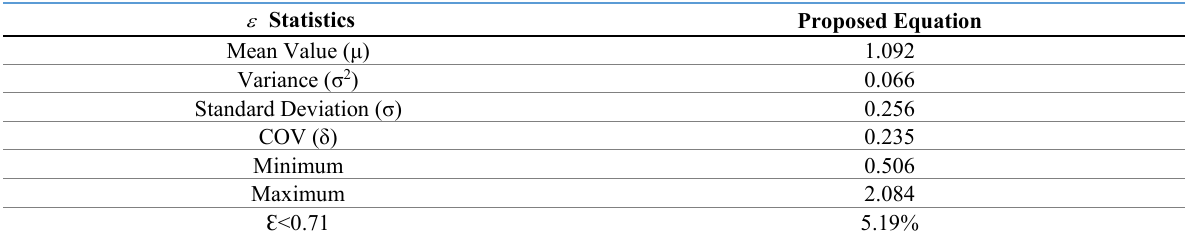
Table 4. Statistics of the model error for the proposed